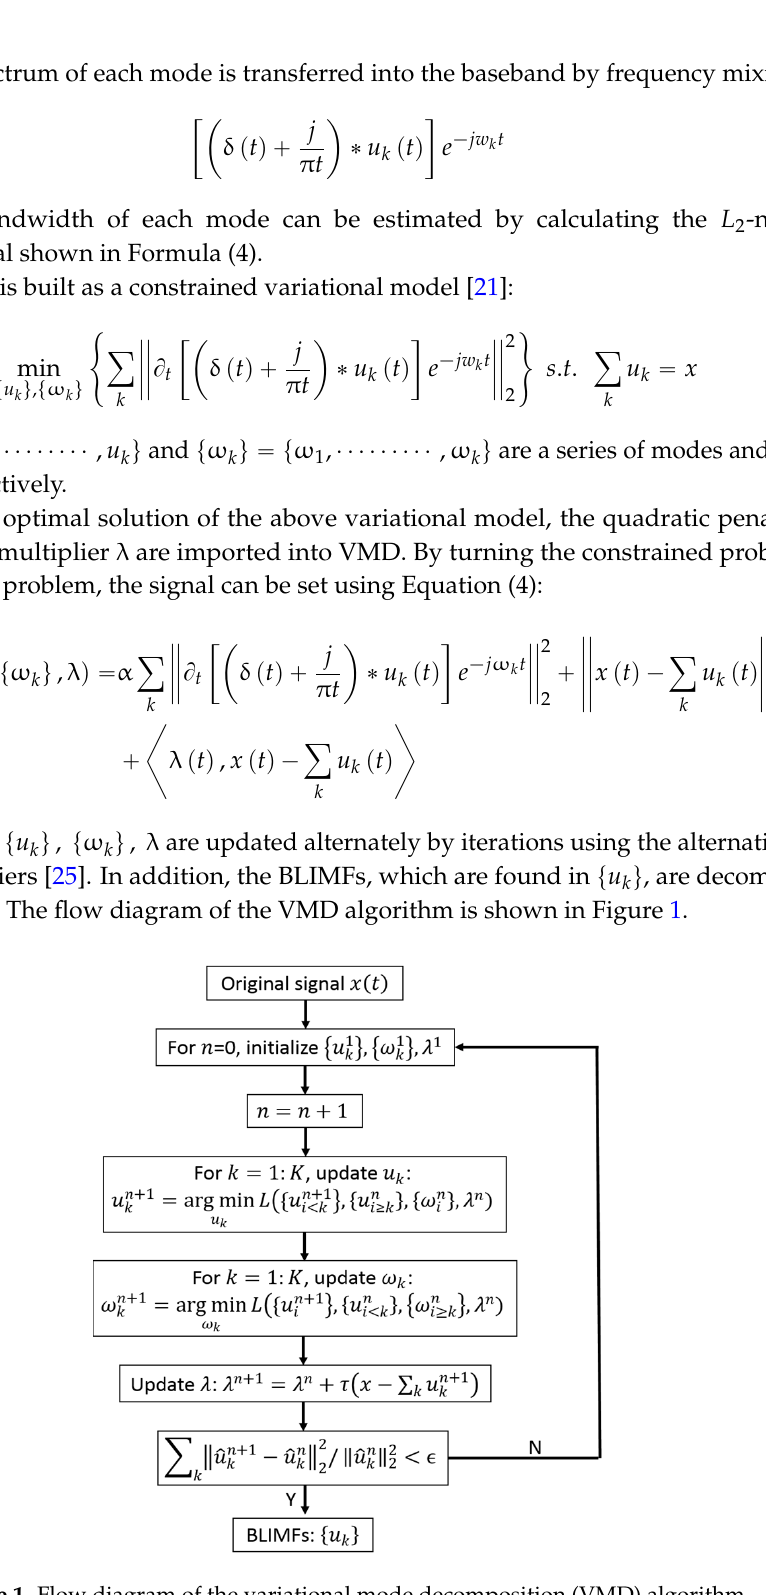
Figure 1. Flow diagram of the variational mode decomposition (VMD) algorithm.